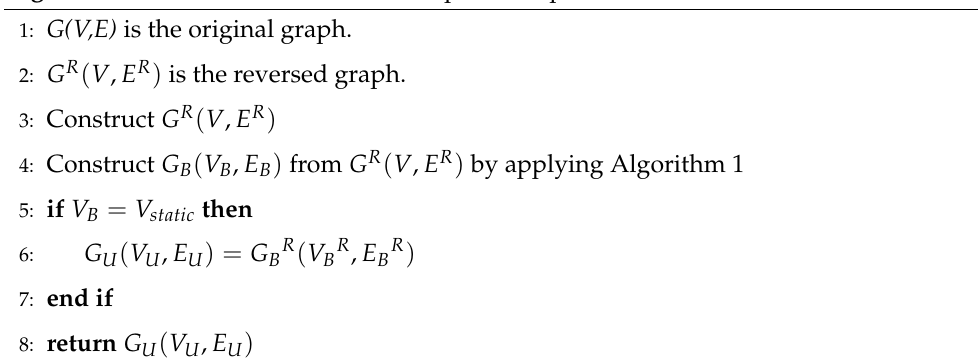
Algorithm 2 Pseudocode for Skeleton Uplink Graph Construction